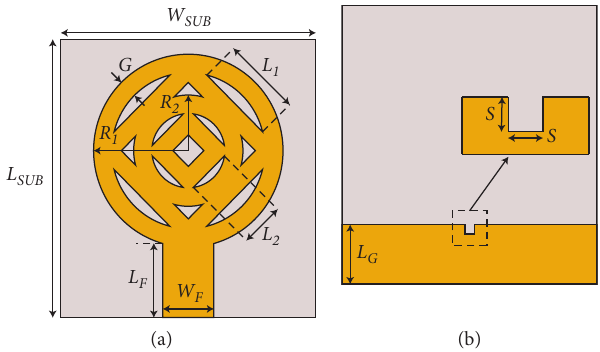
Figure 1: Schematic of the proposed fractal antenna: (a) front side; (b) back side.